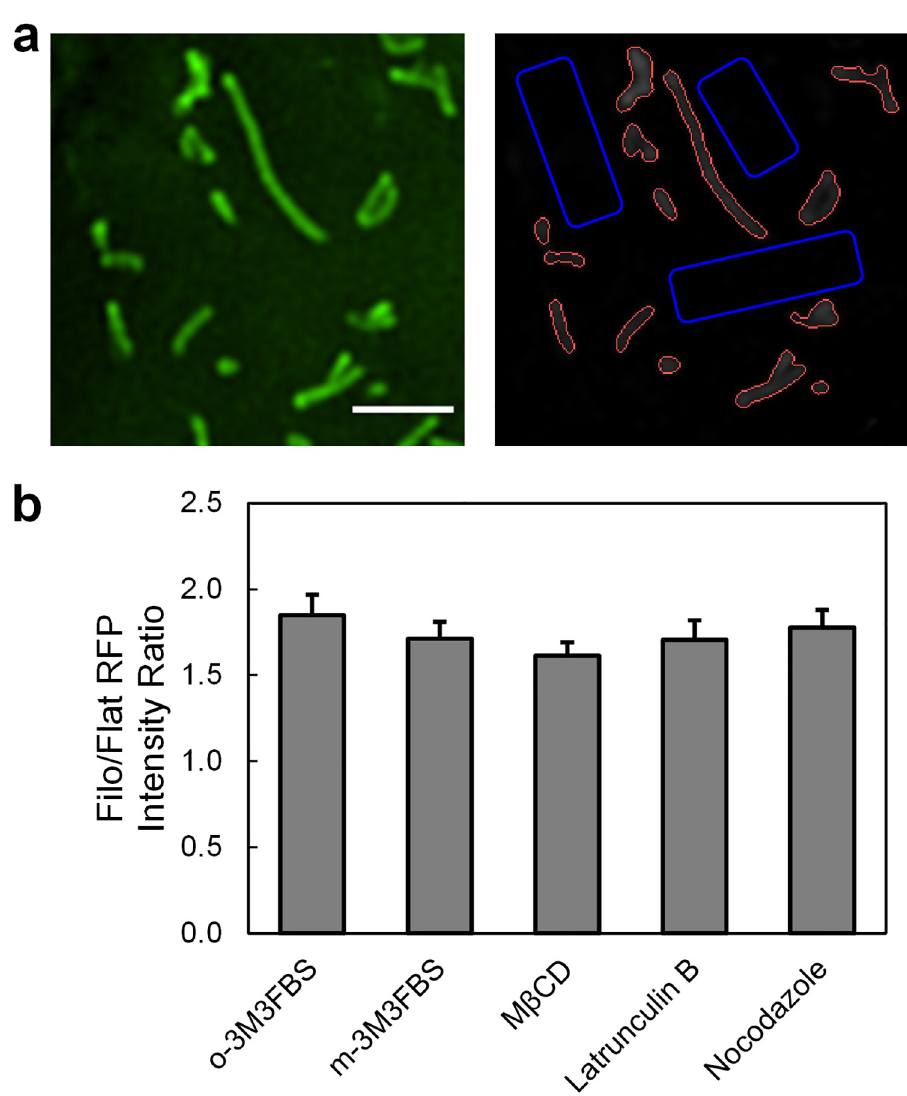
Fig 6. Lack of effect of cholesterol/PIP 2 depletion and cytoskeleton disruption on asymmetric DAT membrane distribution. (a) Ratio of RFP-DAT intensity in the membrane edge/protrusions (red areas) to that in flat membrane regions (blue areas) was calculated for HWK-293T cells treated with o-3M3FBS (control), m-3M3FBS, M β CD, latrunculin B, and nocodazole. (b) A total of 9, 16, 11, 12 and 16 field of views were examined for each condition respectively in three independent experiments. o-3M3FBS (inactive analog of m-3M3FBS) was used as the control group. p > 0.05 for all groups vs control, unpaired Student’s t-test.